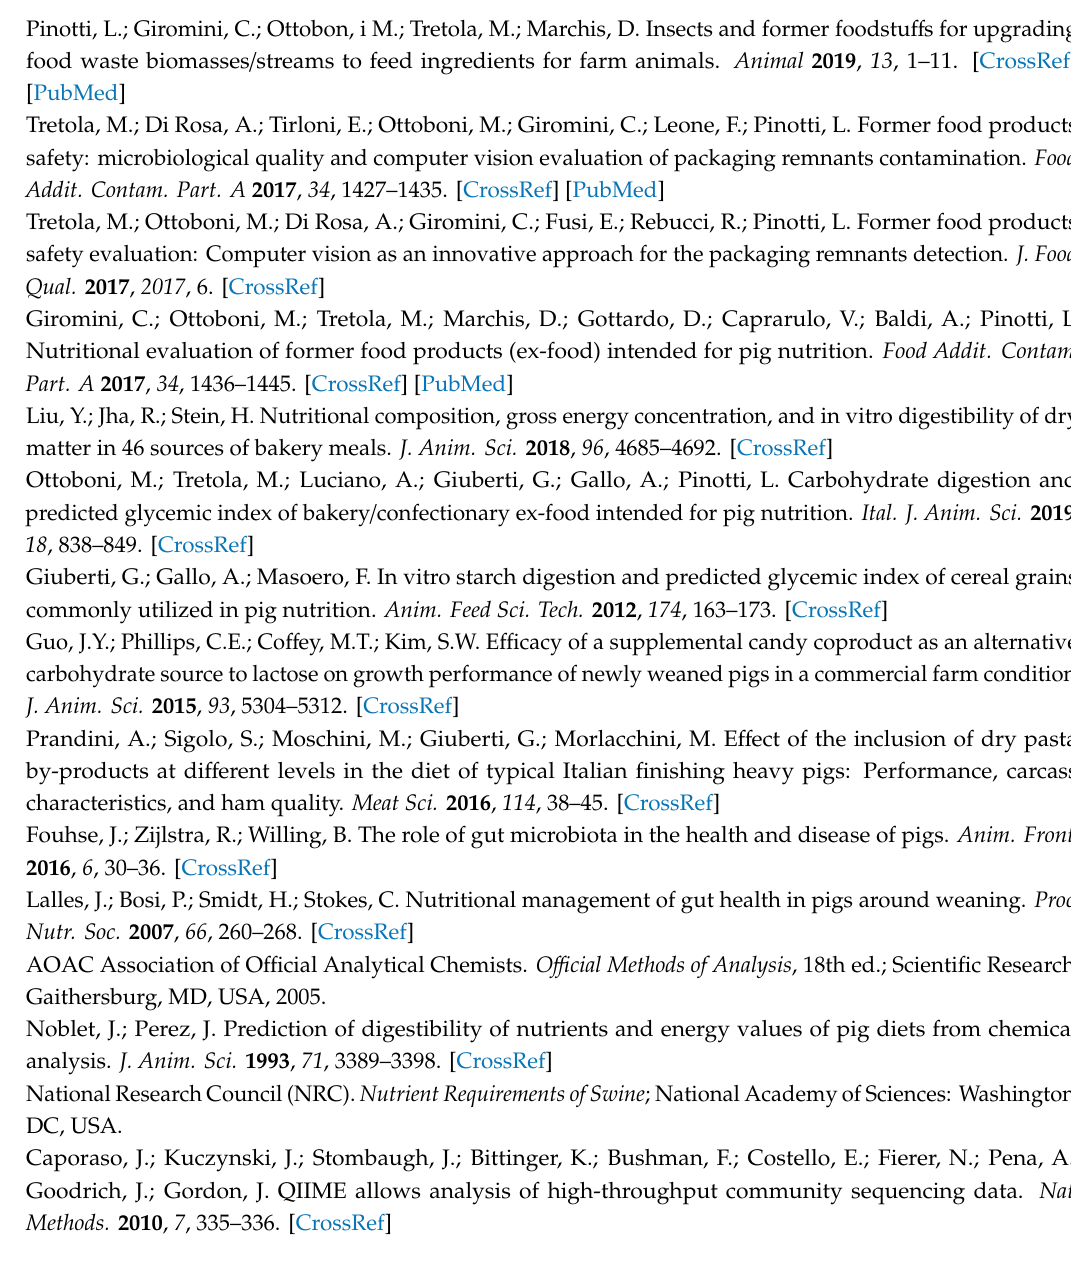
Table S1: Ingredient composition (g / 100 g of diet) of the two experimental diets, Table S2: Analysed composition (g / 100 g or MJ / kg on DM) of the CTR and FFP diets, Table S3: Per sample abundance of sequences after the quality check of reads, Figure S1: Rarefaction plots per group in di ff erent time